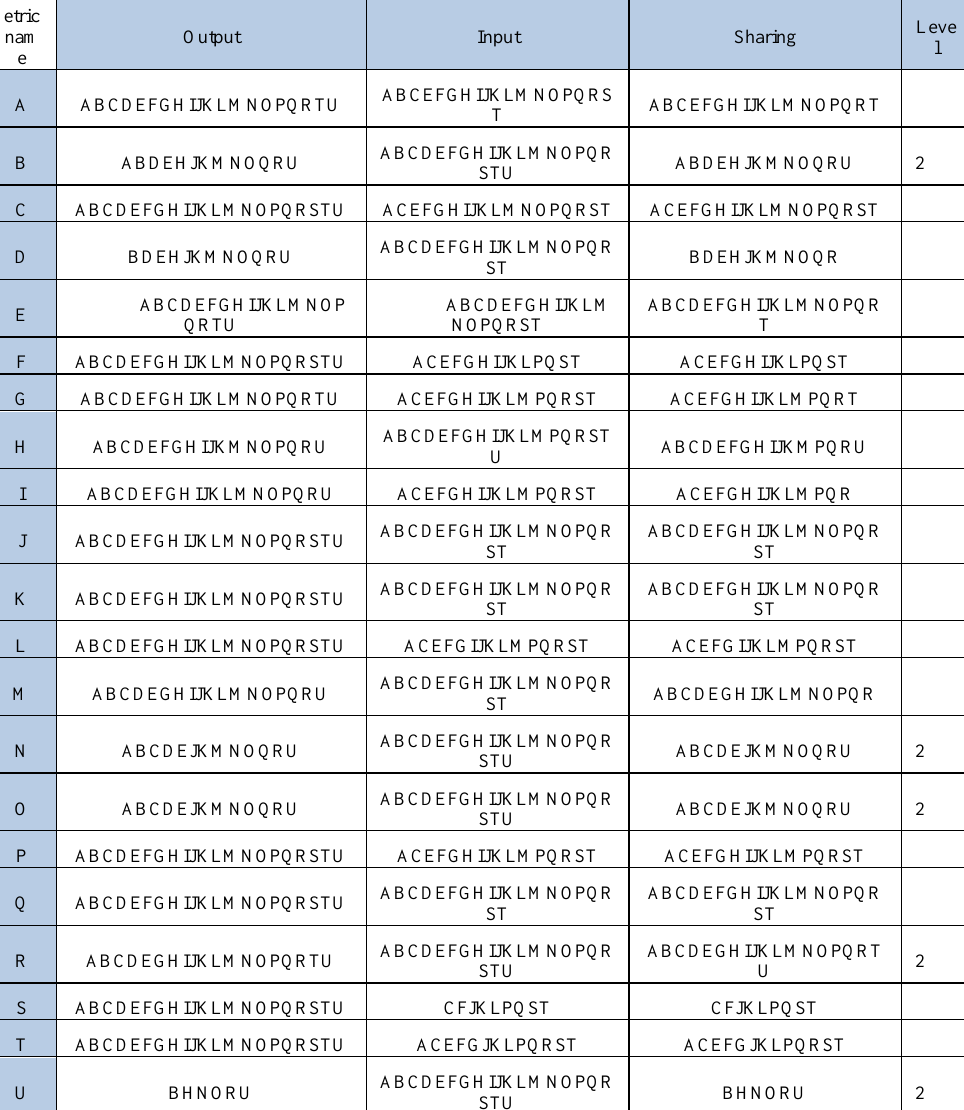
Table 5. Level 2